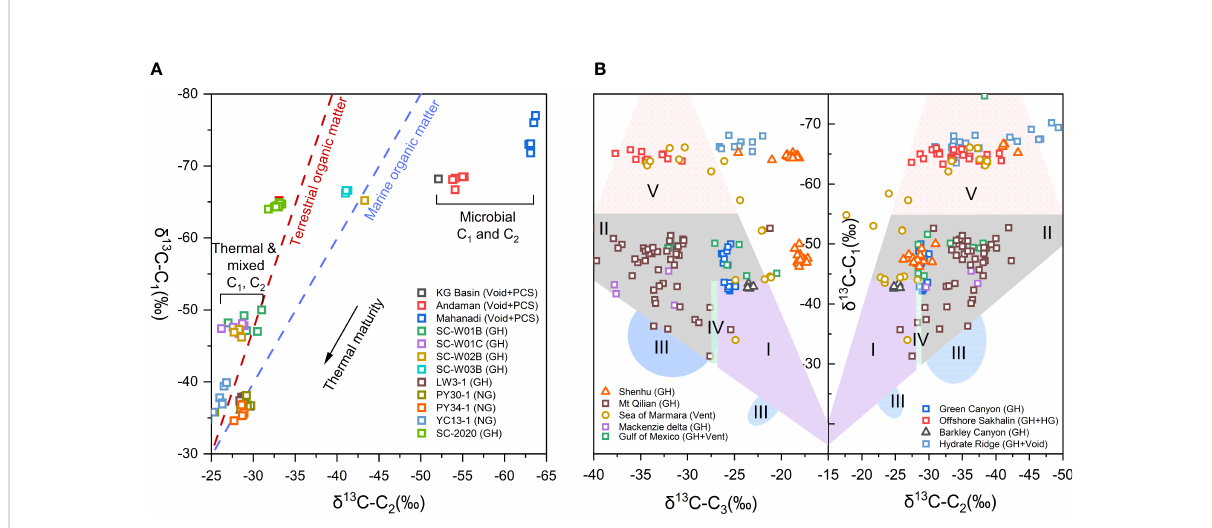
FIGURE 6 (A) Relationship of different types of organic matter in the source rocks and hydrate-associated gas. The diagonal lines are adapted from (Lorenson and Collett, 2018). VG-Void Gas, PCS-pressure core gas; GH-Gas Hydrate dissociated gases; NG-Natural gas. (B) Plot of the d 13 C 1 , d 13 C d 13 C 2 , and 3 values of the hydrate-bound gas samples. The genetic diagram is adapted from (Dai, 1992).(I-Humic type gas; II-Sapropel type gas; III-Gas mixture with the reversal of carbon isotope; IV-Humic type gas and sapropel type gas; V-Biogenic gas).